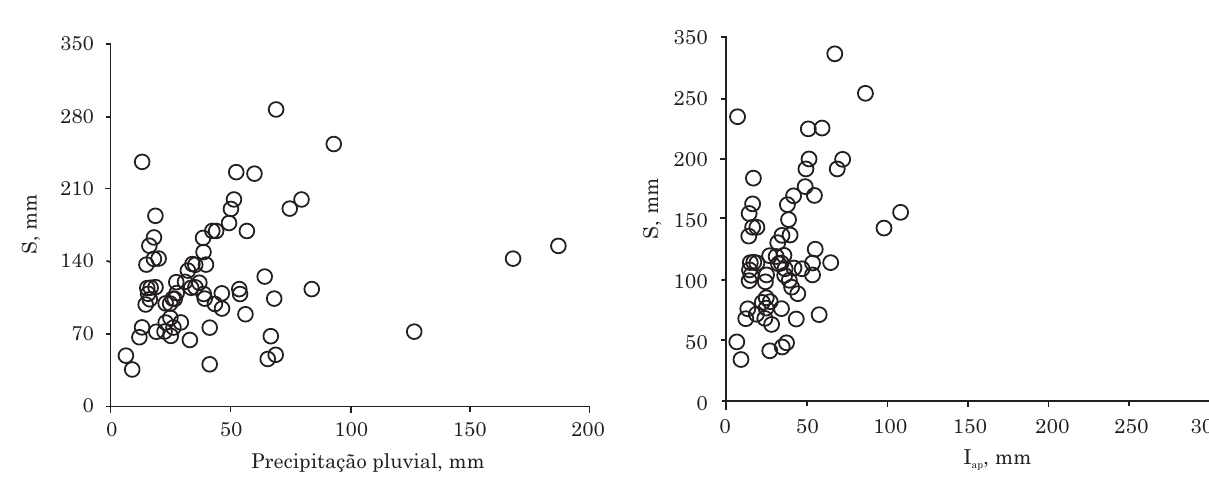
Figura 3. Relação entre as estimativas de infiltração evento a evento pelo método da Curva Número (S) e da infiltração total aparente (I ap